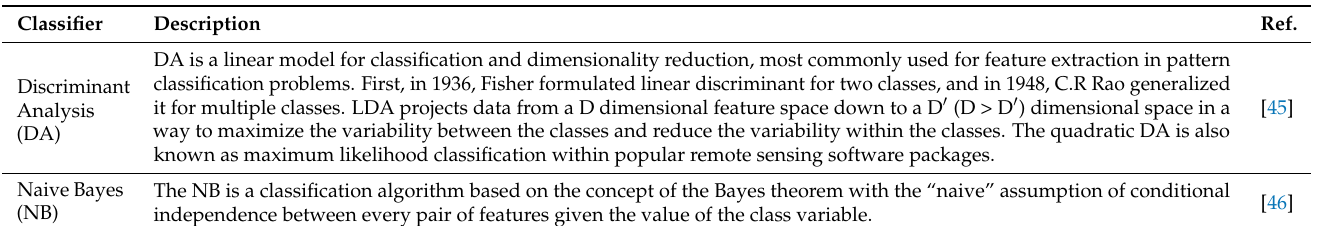
Table 1. Implemented parametric classifiers into MLCA toolbox.